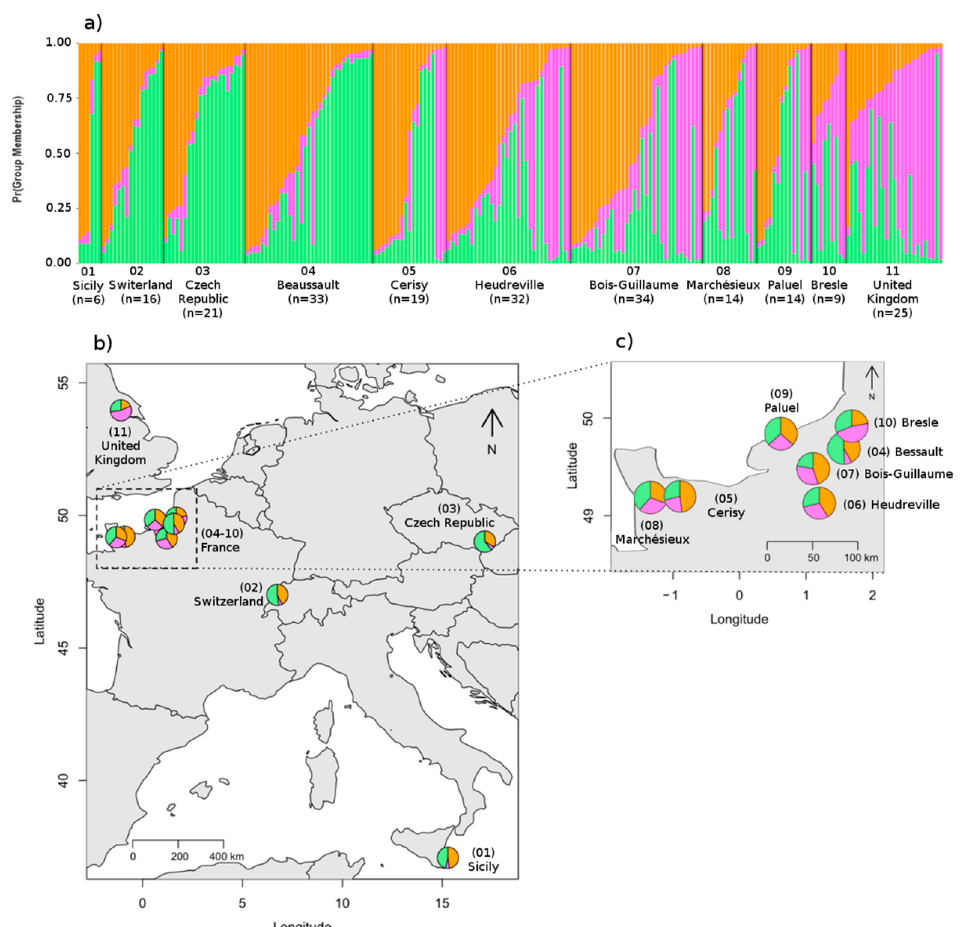
Figure 2. Results of individual assignments to each cluster by STRUCTURE. ( a ) Probabilities of individual membership in the 11 sampled populations, with bars representing individuals and colours representing the probability of belonging to the three genetic clusters identified with STRUCTURE. ( b ) Mean membership in the 11 sampled populations in Europe to each of the three clusters. French populations are delimited in a dotted rectangle. ( c ) Enlarged view of the French populations.